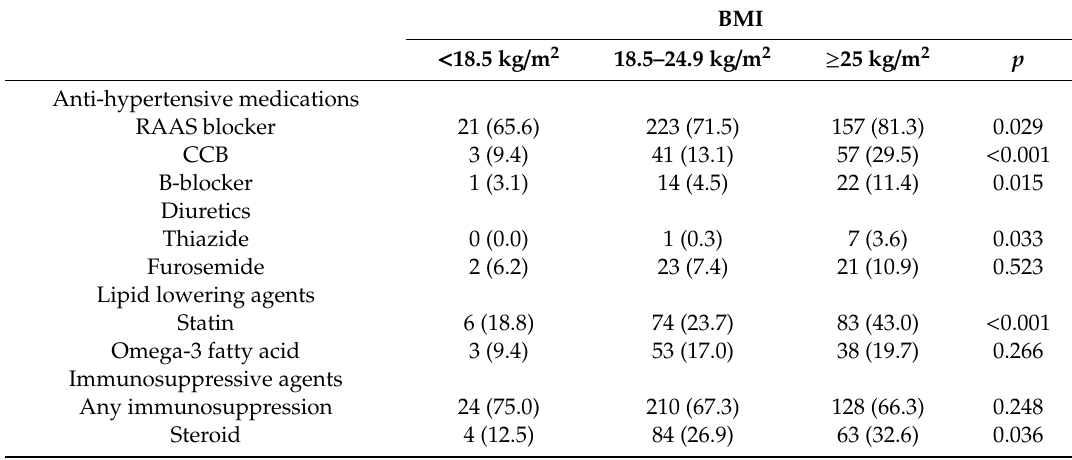
Table 7. Distribution of treatment after renal biopsy according to the three BMI